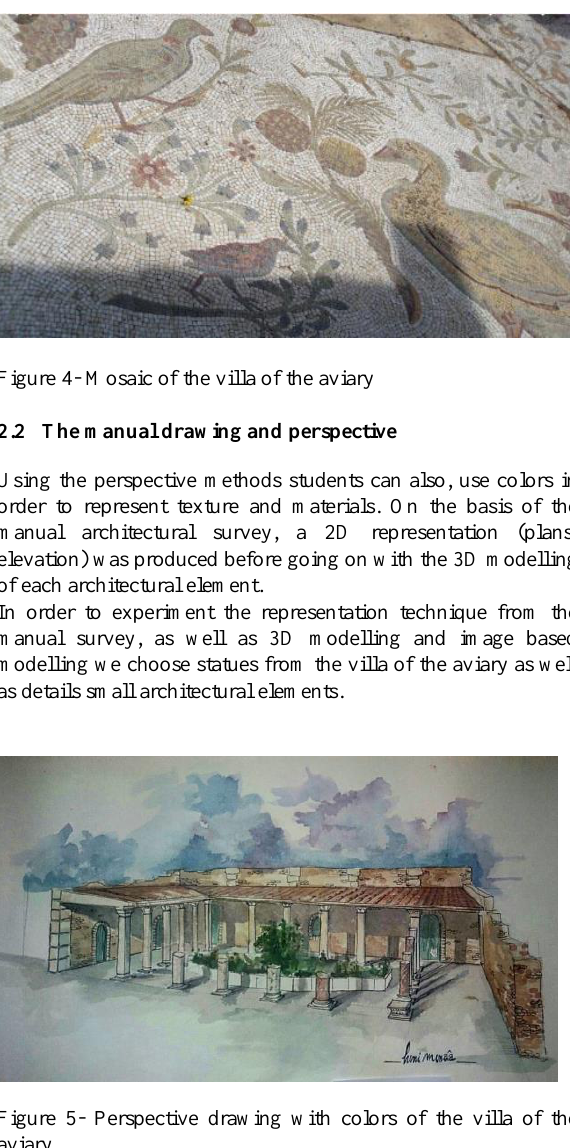
Figure 3- Picture of the villa of the aviary